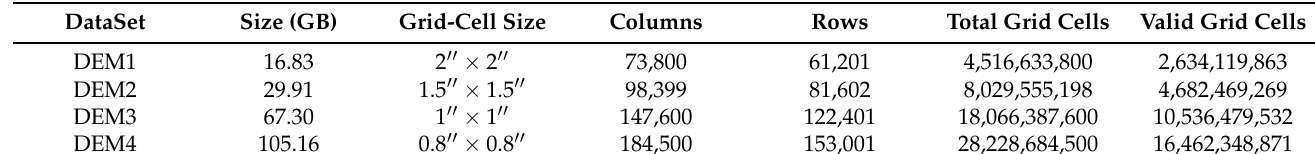
Table 2. Experimental datasets.